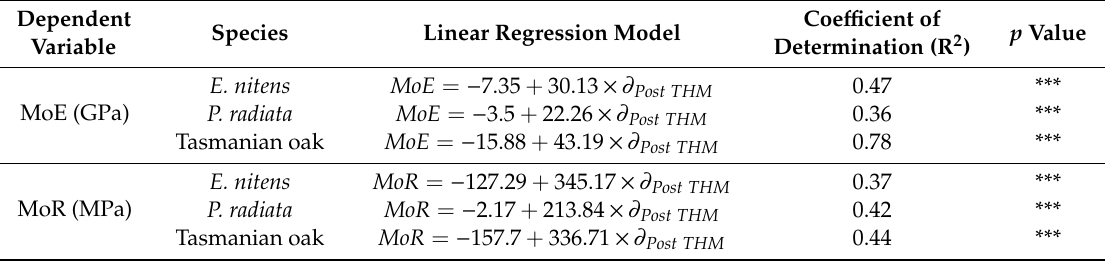
Table 3. Prediction of structural properties for the densified material ( E. nitens , n = 28; P. radiata , n = 30; Tasmanian oak, n = 27).